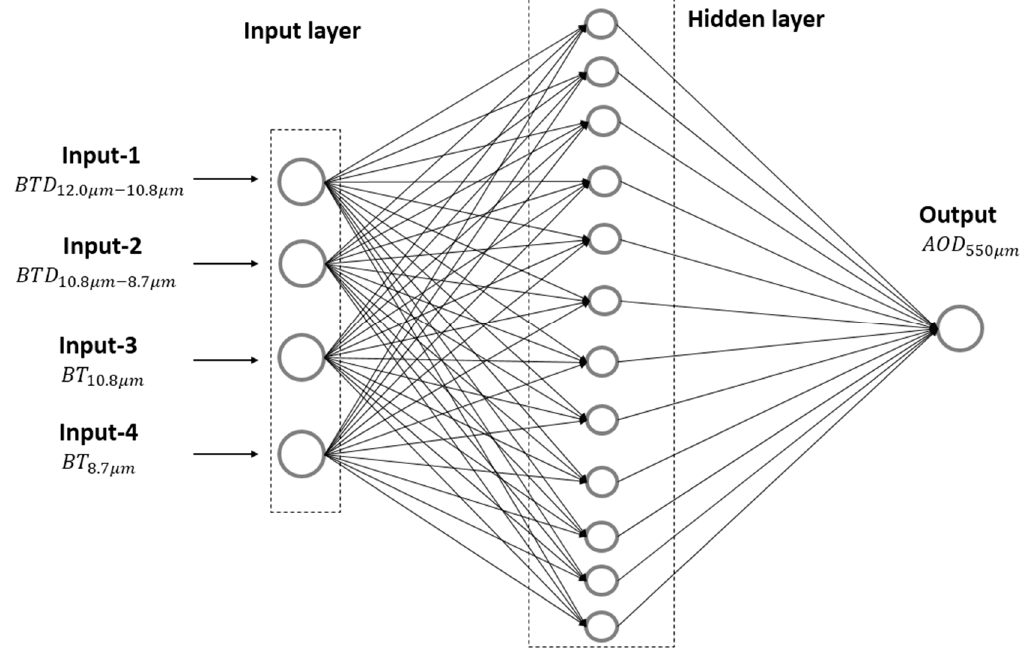
Figure 4. A simplified scheme of the architecture of the ANN model with its input nodes, brightness temperature (BT) and BT difference (BTD), and output (AOD 550 nm ) nodes.